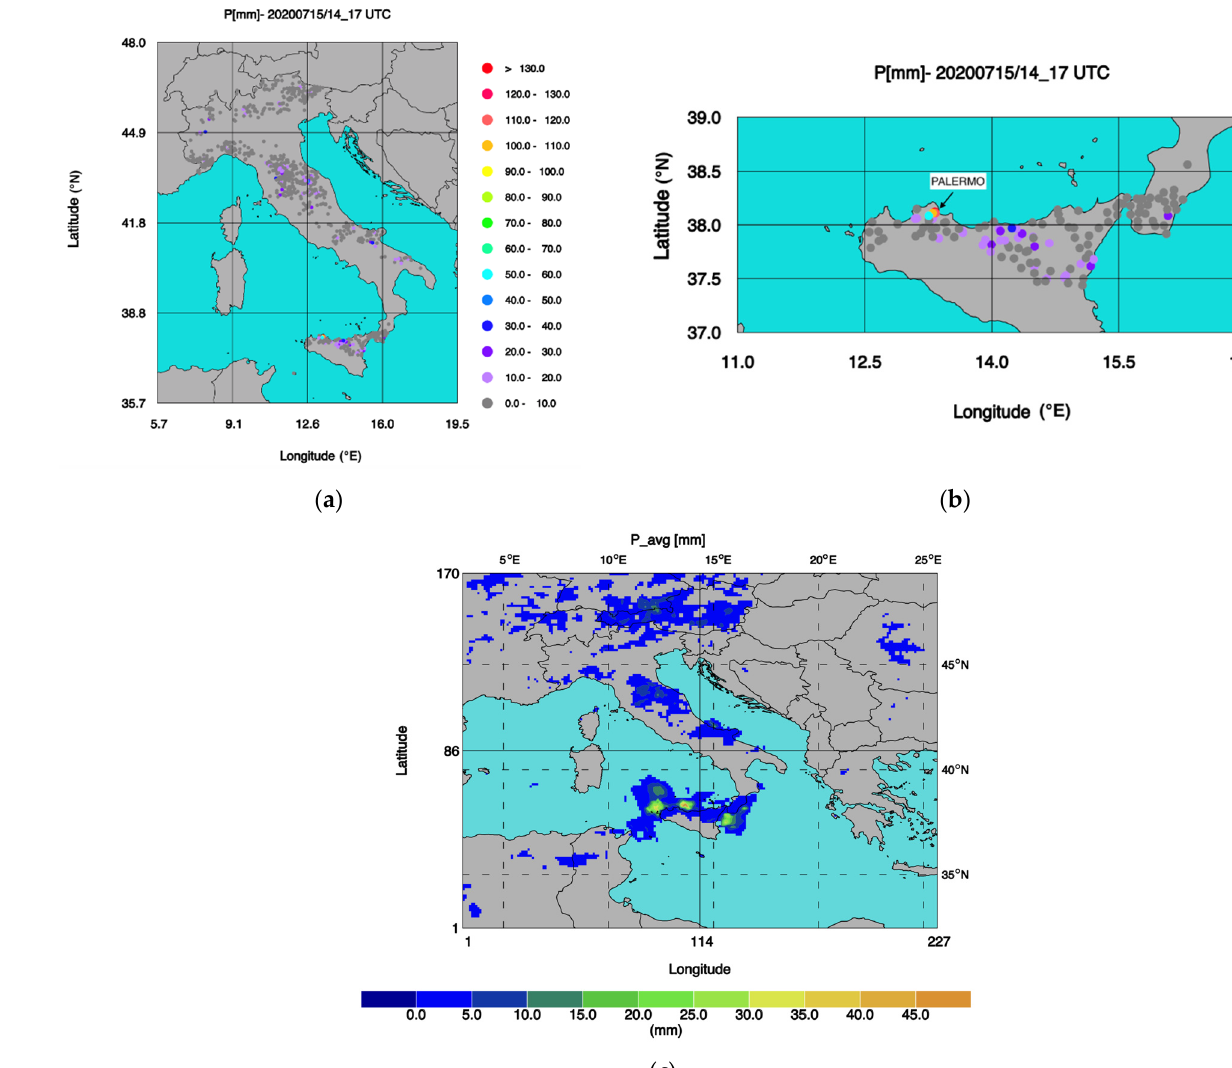
Figure 5. Observed precipitation between 14:00 and 17:00 UTC on 15 July 2020 from rain gauges for: ( a ) Italy; ( b ) Sicily and part of Calabria. The rain gauge network belongs to the Italian regional administrations, whereas the data are collected nationwide by the Department of Civil Protection. ( c ) Precipitation between 14:00 and 17:00 UTC from GPM-IMERG Final